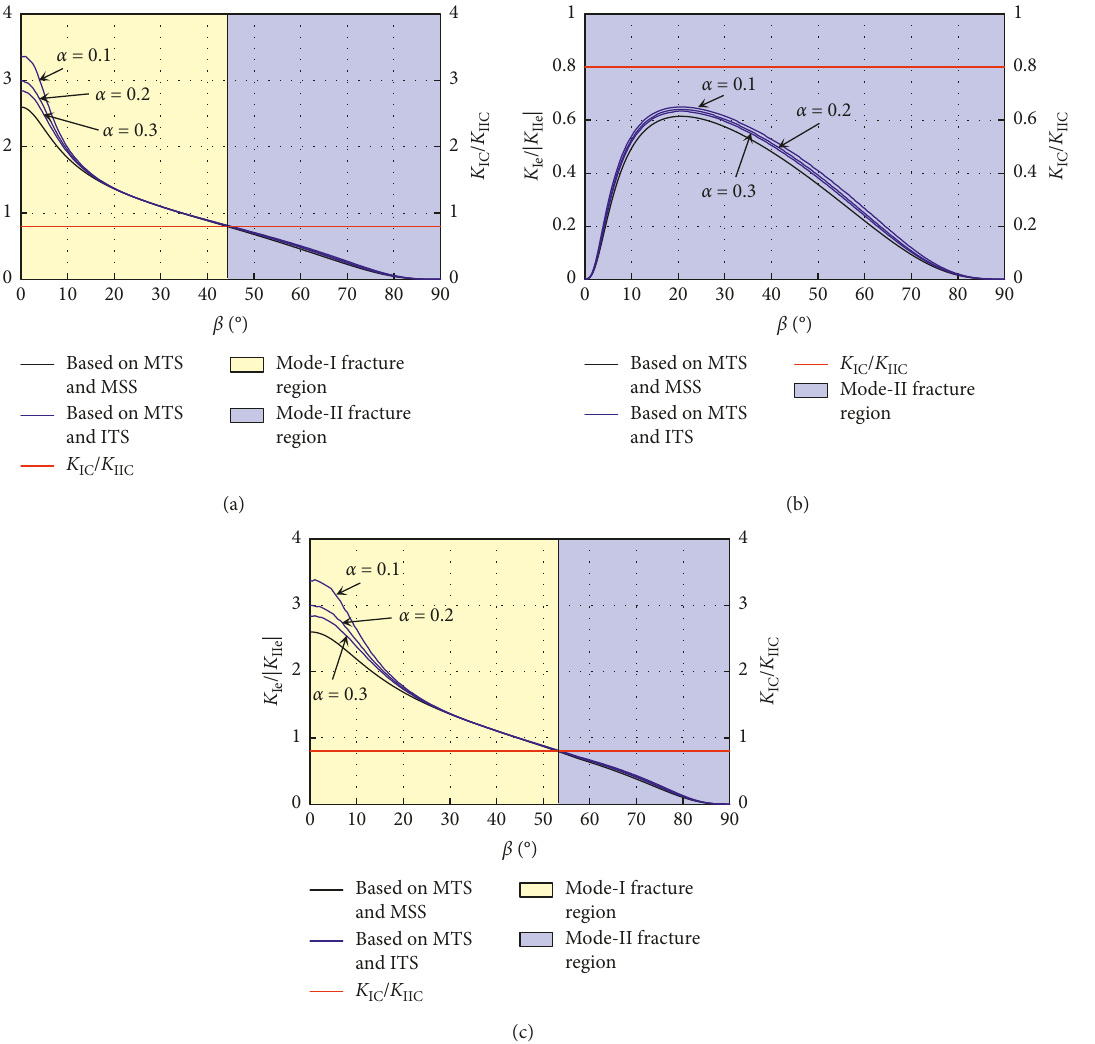
Figure 4: Mode I-II fracture regions for mixed mode I-II nonclosed cracks: (a) σ ∞